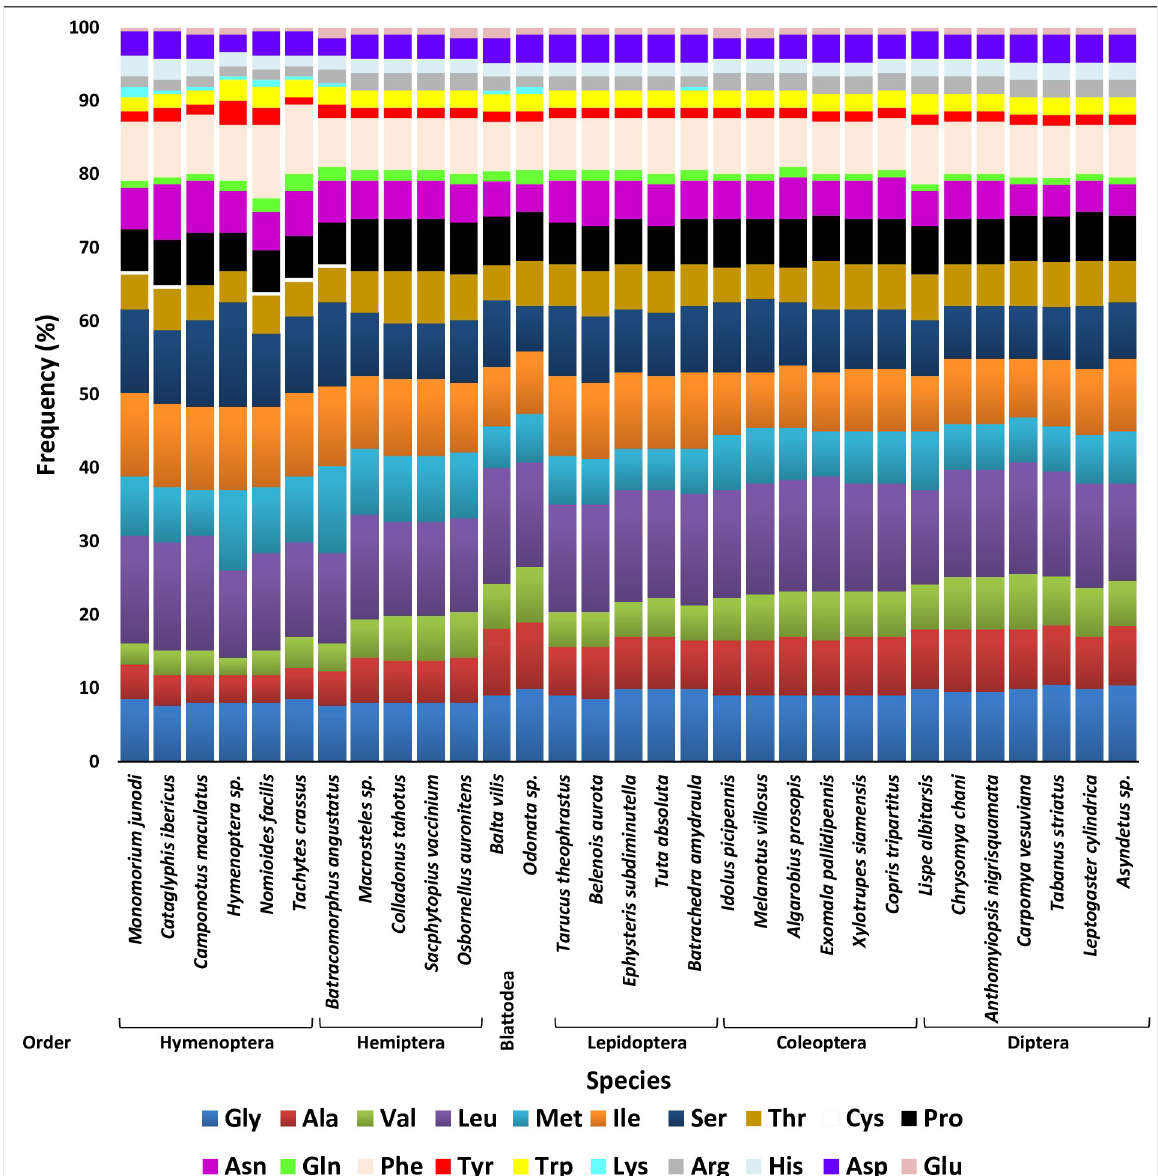
Fig 2. Distribution of aminoacids within the barcodes across six insect orders. Amino acid frequencies in barcode sequences of species of six insect orders in addition to an Odonata sp. used for comparison. AAs are grouped vertically based on their biochemical properties.